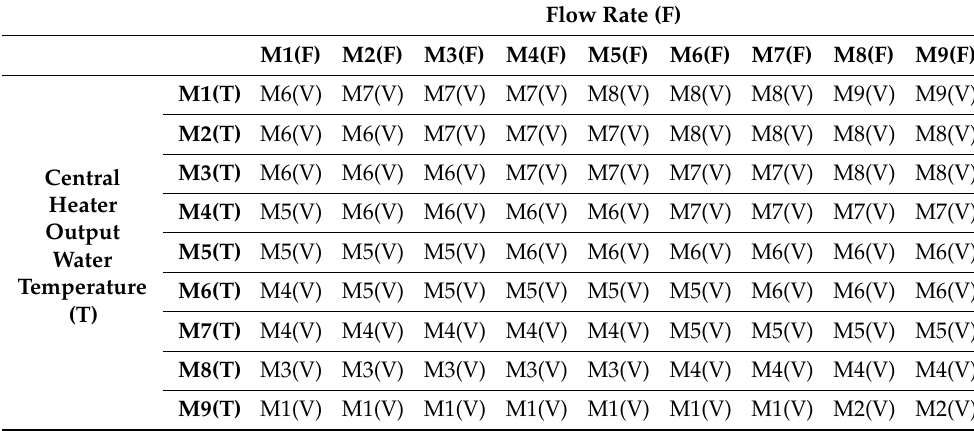
Table 1. Fuzzy rules for the inline water heater